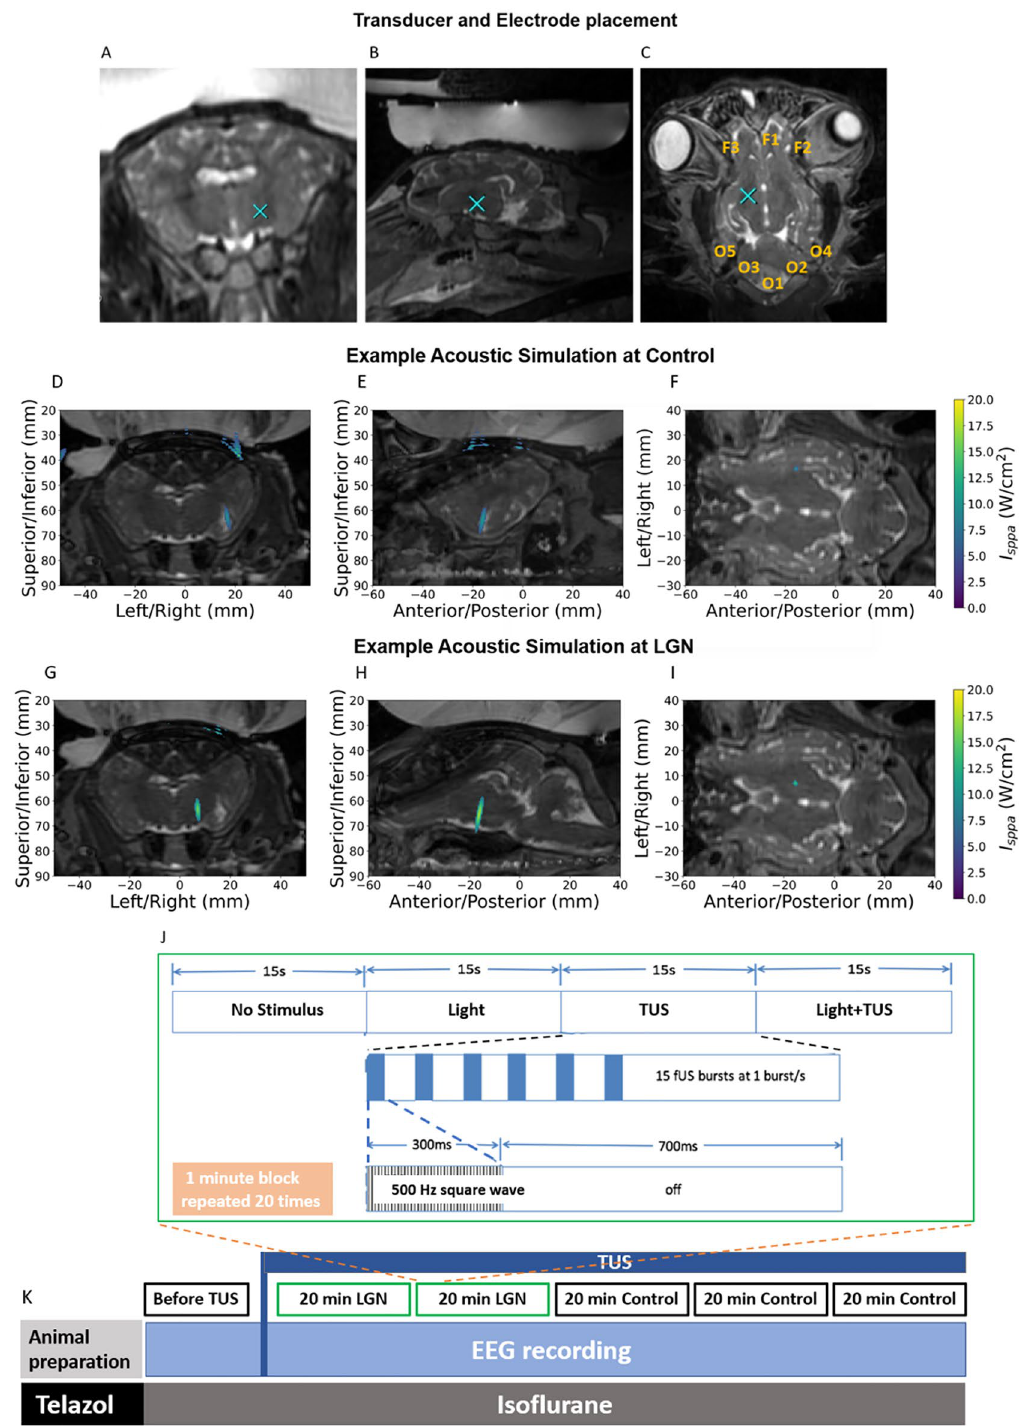
Figure 1. Imaging and experimental paradigm. Coronal ( A ), sagittal ( B ) and axial ( C ) MR images with TUS target location at control spot (blue X). The axial image ( C ) also shows the eight electrode locations where each electrode was extracranially placed 10 mm under the skin (orange labels). Acoustic intensities were simulated for example sonications using the hybrid angular spectrum method and overlaid on coronal ( D ), sagittal ( E ), and axial ( F ) MR images at control location, and ( G ), ( H ) and ( I ) at the LGN. In this particular example the intensity at the control location is slightly lower, however this was not always the case. Other than one experiment with substantial difference in intensity values due to a larger steering angle at control, the intensity values are comparable. Each 20-min block ( J ) was split into 20 sections, each with four 15 s conditions consisting of 1) no stimulus, 2) light stimulus only, 3) TUS-only, and 4) light stimulus-plus-TUS. For each 15-s condition the repetition frequency of the stimulus was 1 flash/s. The ultrasound stimuli were 300 ms pulse trains of square waves of 50% duty cycle, repeated every second. The visual stimuli were 20 ms white-light flashes (binocular at 1 Hz). The block diagram of the entire experiment timeline is shown ( K ). Before applying TUS, baseline VEPs were recorded for 5 min. Then the 20 min block was applied with sonication directed to either left or right LGN. This was repeated for a second 20 min block. At that point, the sonication was directed to a control non-LGN location (10 mm anterior to LGN, medial putamen and adjacent internal capsule) for three blocks. EEG was recorded continuously during each